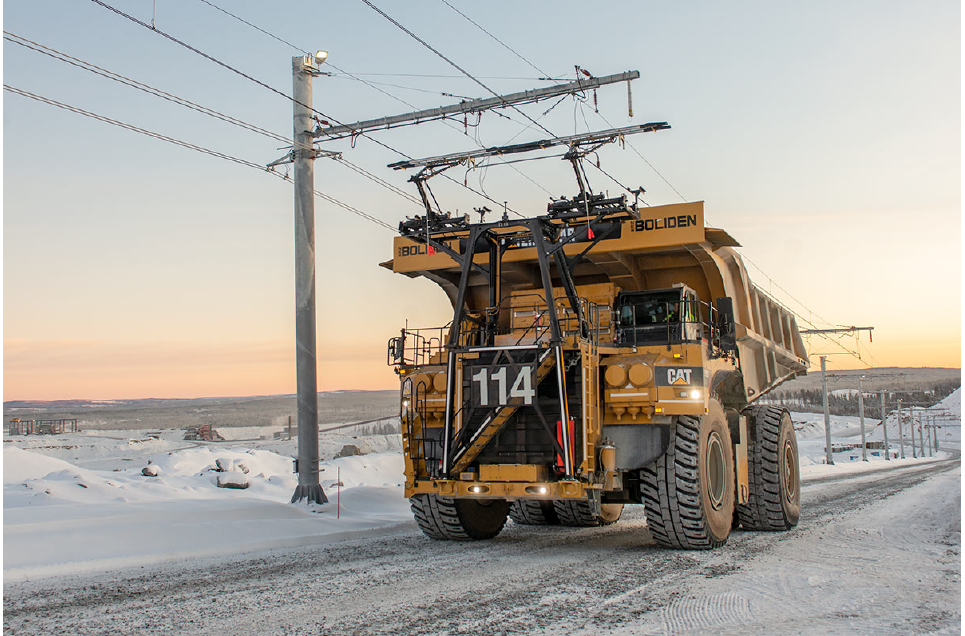
Figure 1. Haul truck connected to an overhead electric road system in the Aitik mine. (Picture: Mats